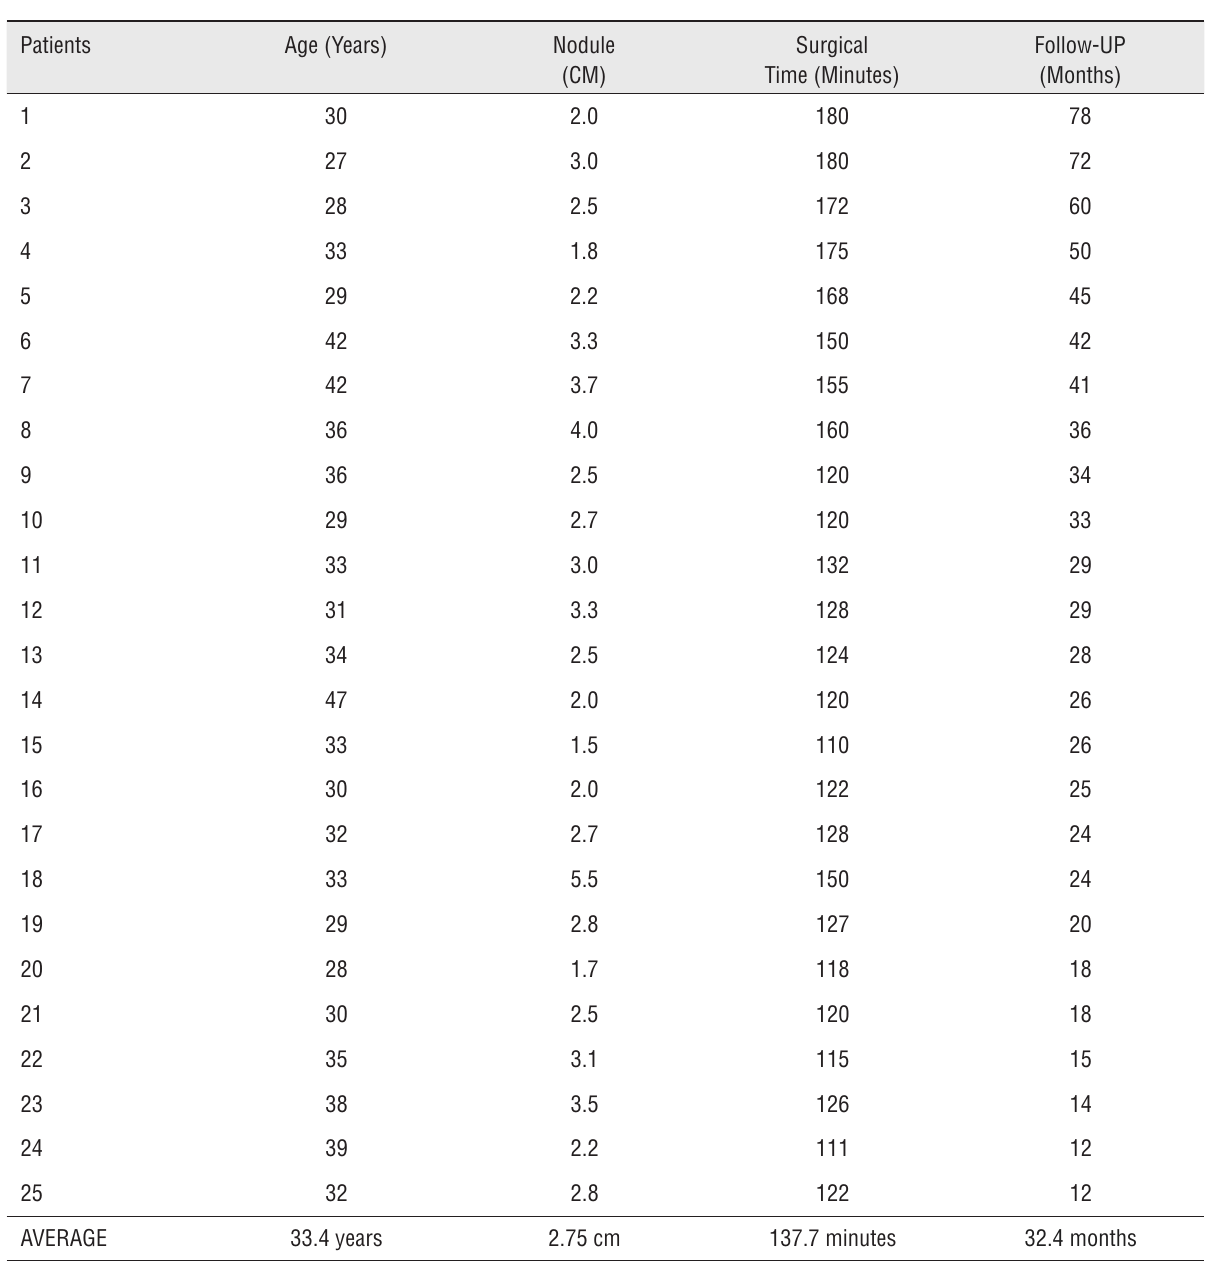
Table 1 - Date table.